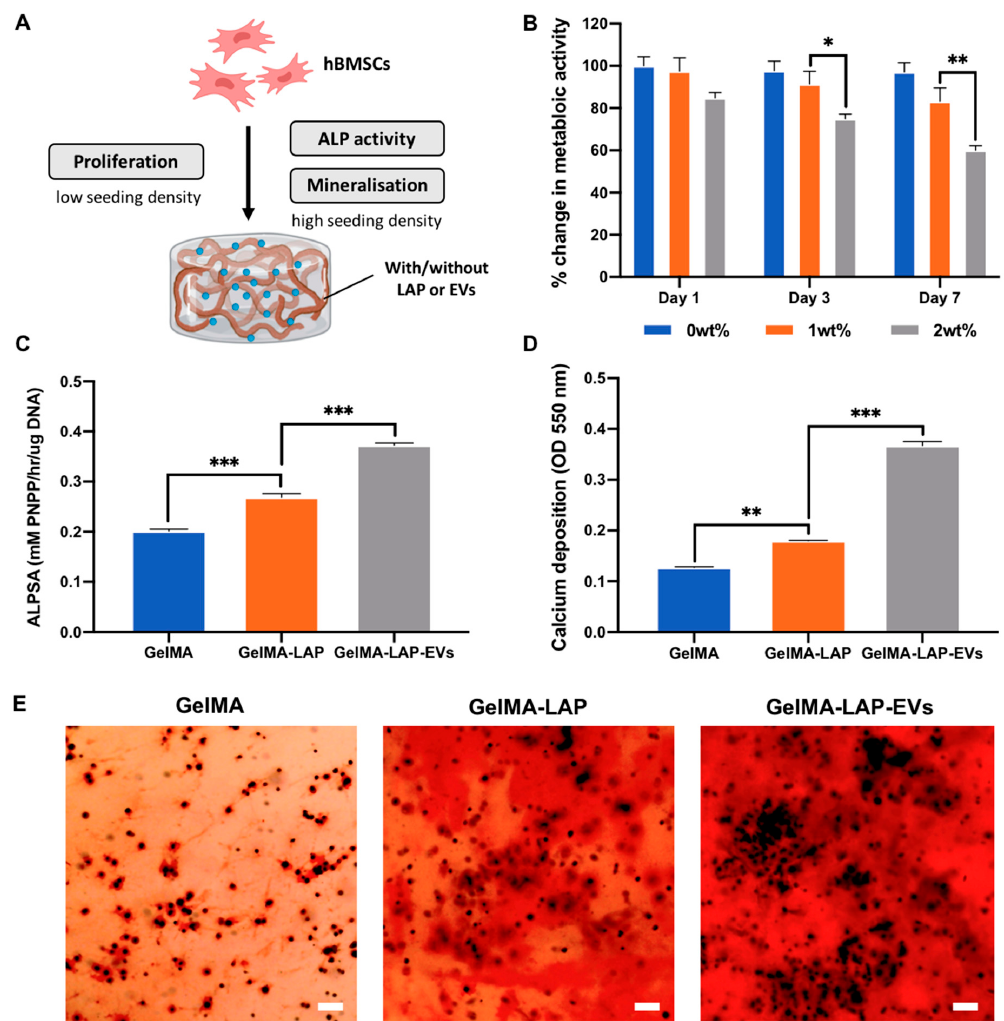
Figure 3. The osteoinductive potency of the GelMA-LAP hydrogel. ( A ) Schematic representation of functional assessments. ( B ) The metabolic activity of hBMSCs within GelMA containing 0, 1 or 2wt% LAP. The effect of LAP and EV loading on hBMSCs ( C ) ALP activity and ( D , E ) calcium deposition within the GelMA hydrogel following 2 weeks osteoinductive culture. Black staining indicates mineral nodules. Scale bar = 100 µm. Data are expressed as mean ± SD ( n = 3). * p ≤ 0.05, ** p ≤ 0.01 and *** p ≤ 0.001.